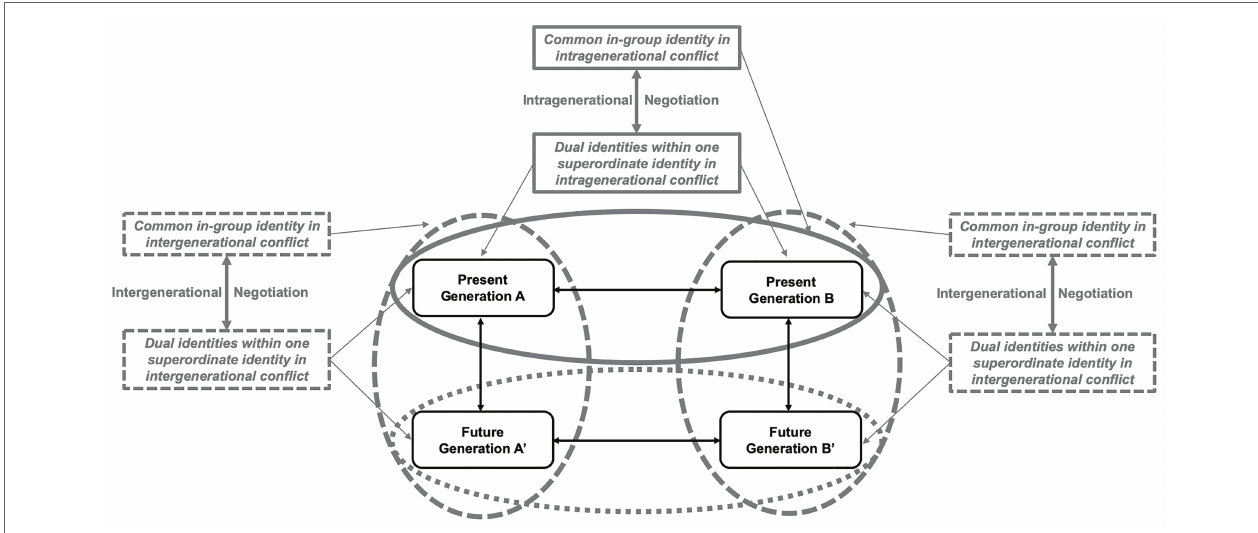
FIGURE 5 | The negotiating-with-future-others strategy for balancing the consideration of interdependent conflicts at the generational level. The horizontal ellipses show how common in-group identity leads to integrative negotiation processes at the intragenerational level between groups. The vertical ellipses show how common in-group identity leads to integrative negotiation processes at the intergenerational level over time. If both groups engage in such intergenerational negotiation processes, they should also be able to balance the consideration of future intragenerational